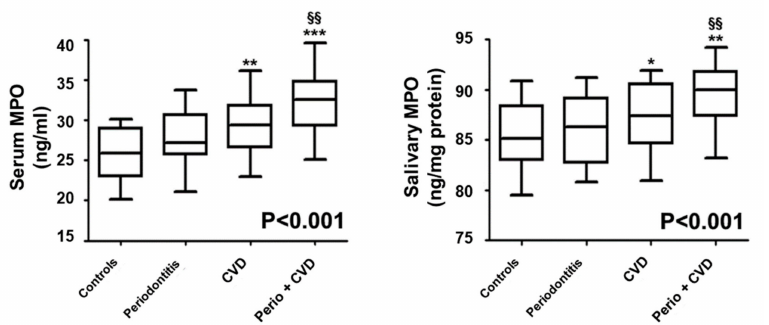
Figure 2. Median values (25%; 75% percentiles) of coronary heart disease (MPO) in saliva and serum. * p < 0.05, ** p < 0.01 and *** p < 0.001 significant di ff erences vs. control subjects (derived by